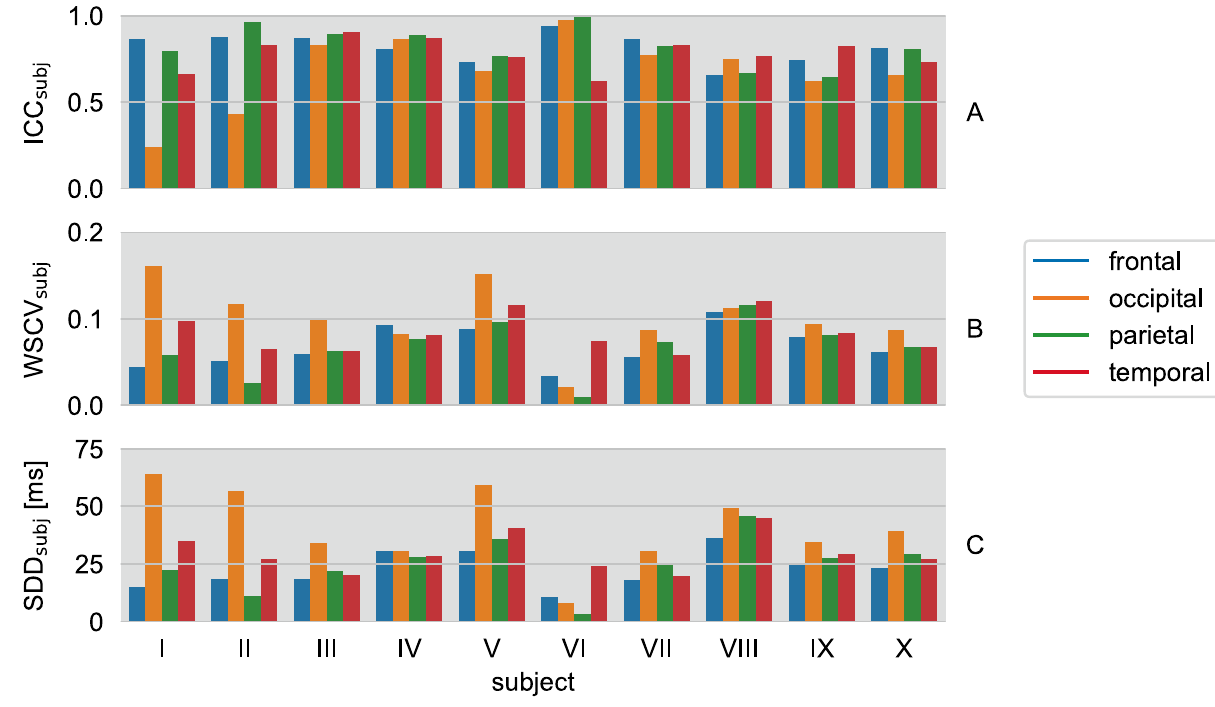
Figure 5. ( A ) Intraclass correlation coefficient ICC subj , ( B ) within-subject coefficient of variation WSCV subj and ( C ) smallest detectable difference SDD subj of median T 2 values from repeated measurements at four postlabeling